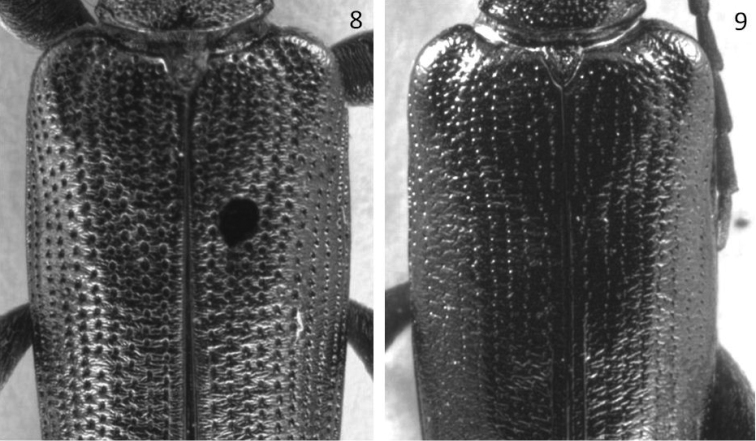
Elytral punctures. 8Donaciaclavareaui9D.fukiensis.